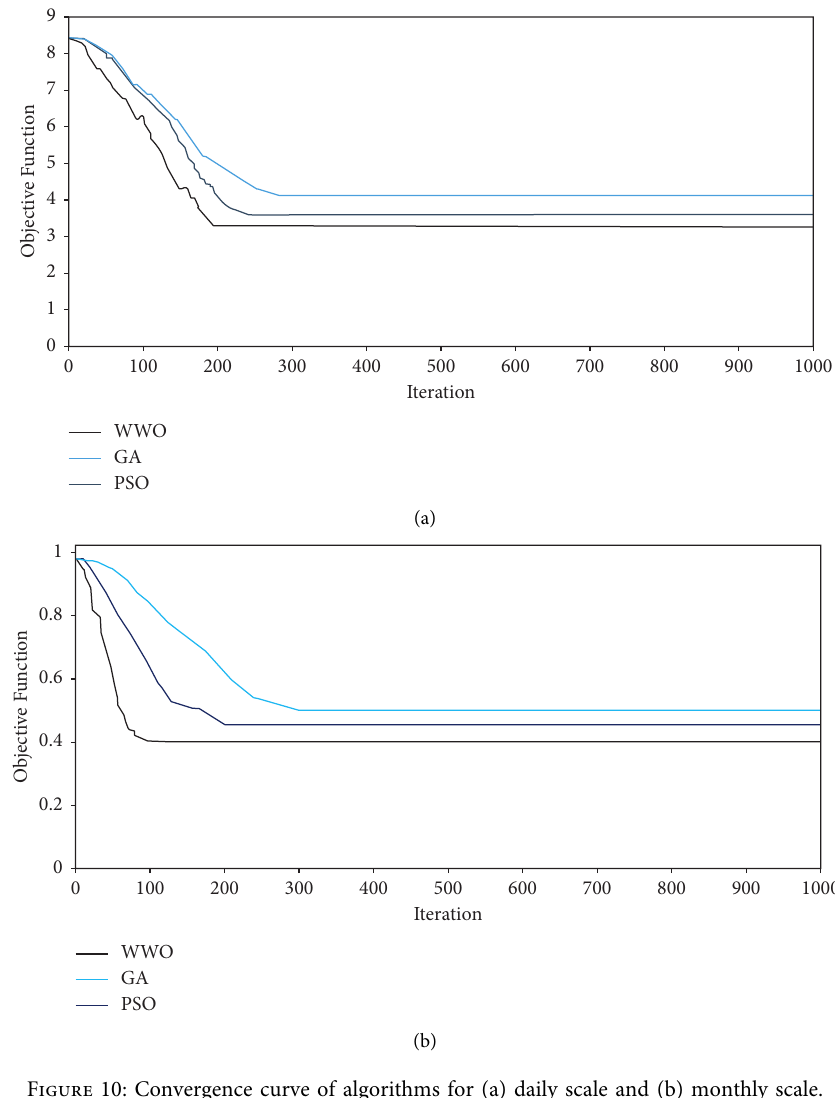
Figure 10: Convergence curve of algorithms for (a) daily scale and (b) monthly